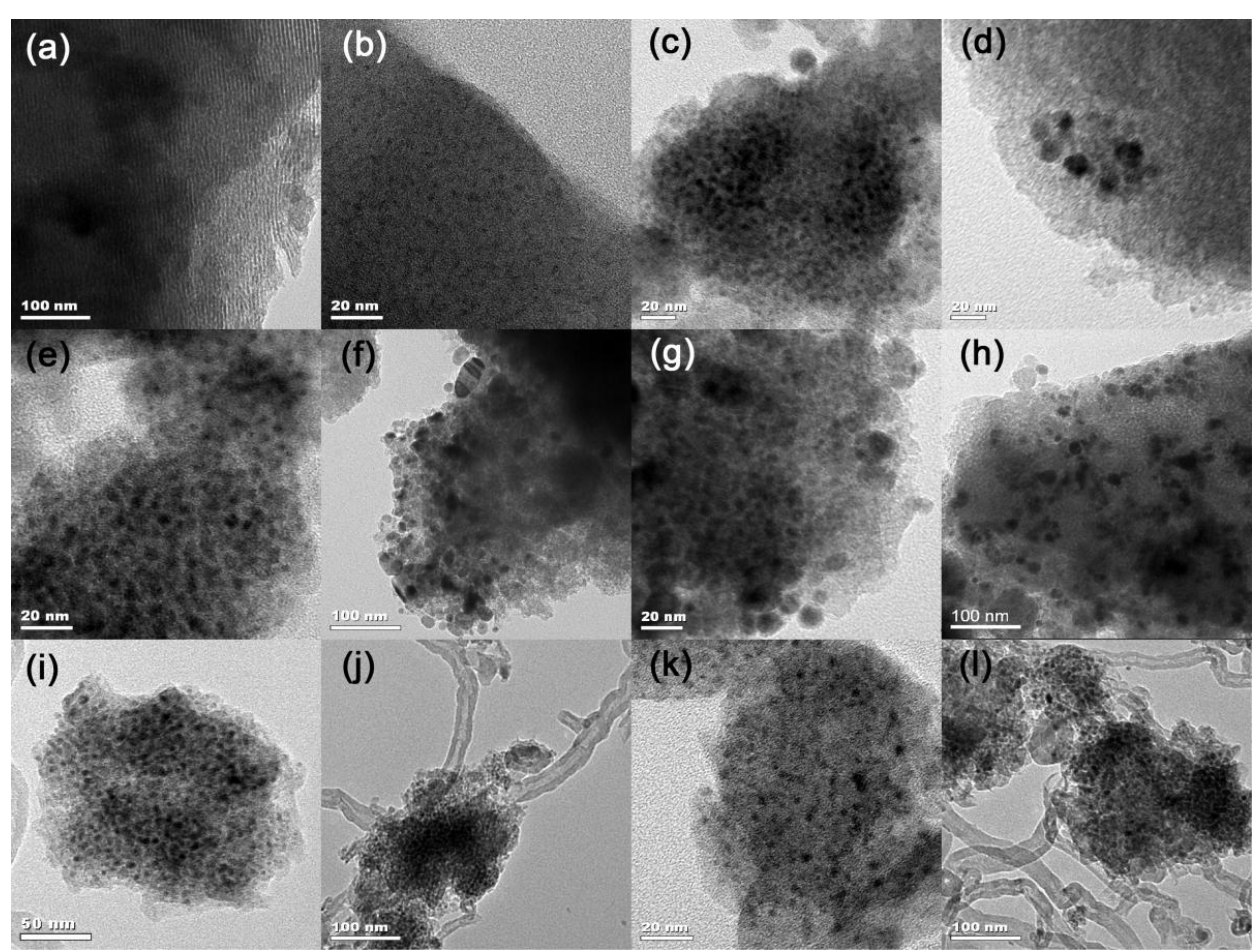
Figure 6. TEM images of ( a – h ) the reduced samples and ( i – l ) the used samples after catalytic